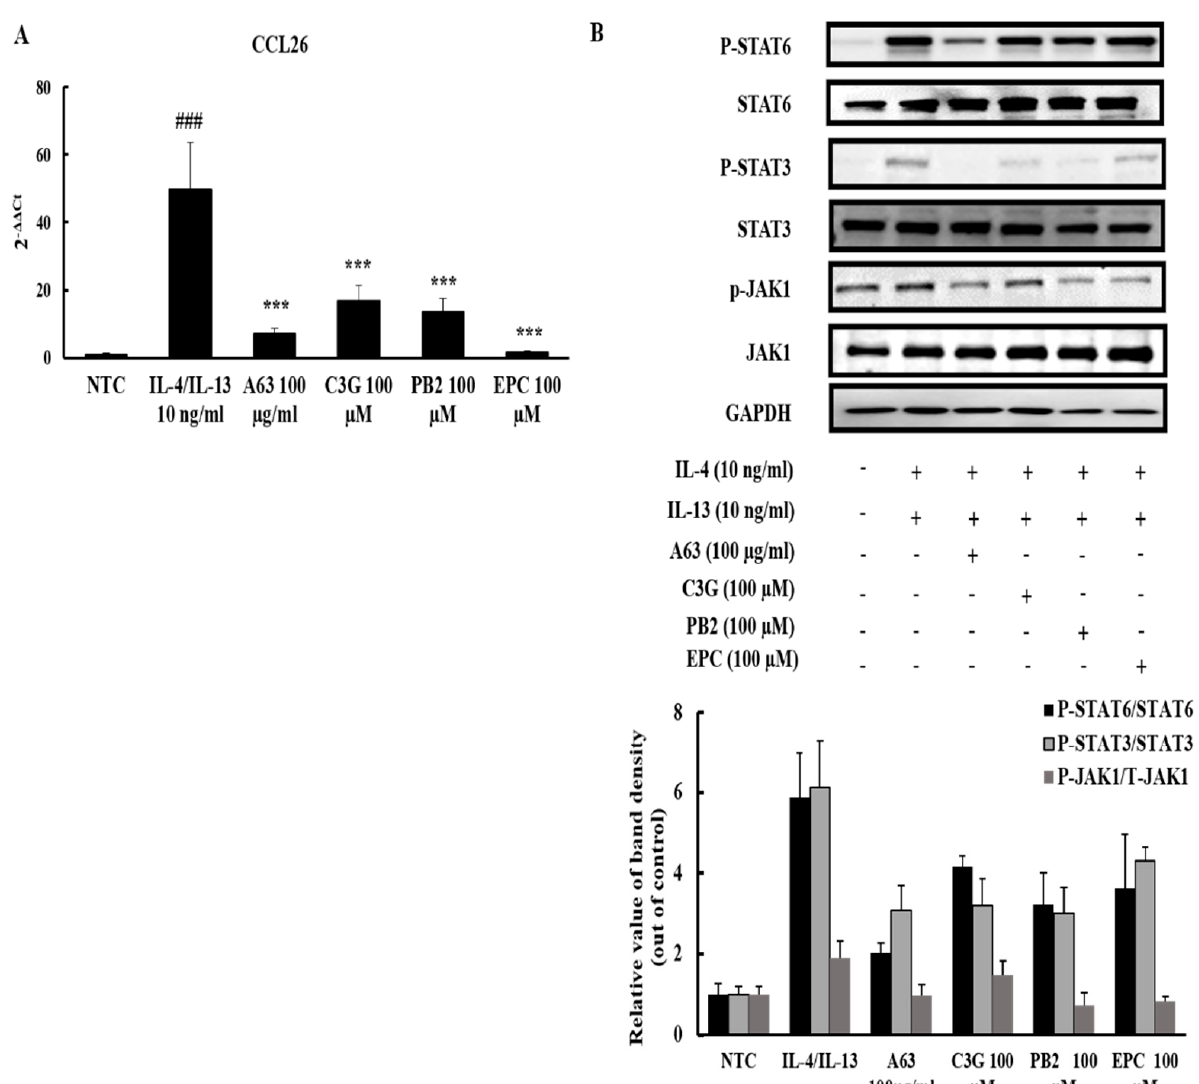
Figure 6. A63 extract prevents eosinophil infiltration toward the inflammatory site via CCL26 expression downregulation and the inactivation of JAK1/STAT6 signaling. qPCR analysis of CCL26 expression in IL-4/IL-13-induced HS68 cells ( A ). Western blot results of IL-4/IL-13-induced HS68 cells ( B ). Results are expressed as mean ± standard deviation (### p < 0.001 versus control group, *** p < 0.001 versus IL-4/13 treated group).